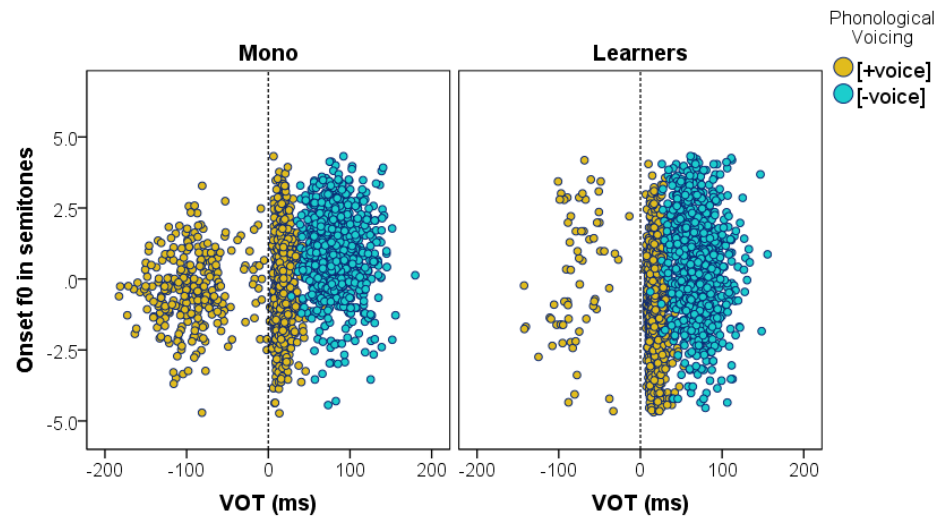
Figure 9. Scatterplots of onset f0 and VOT values in English productions of learners and monolingual speakers.